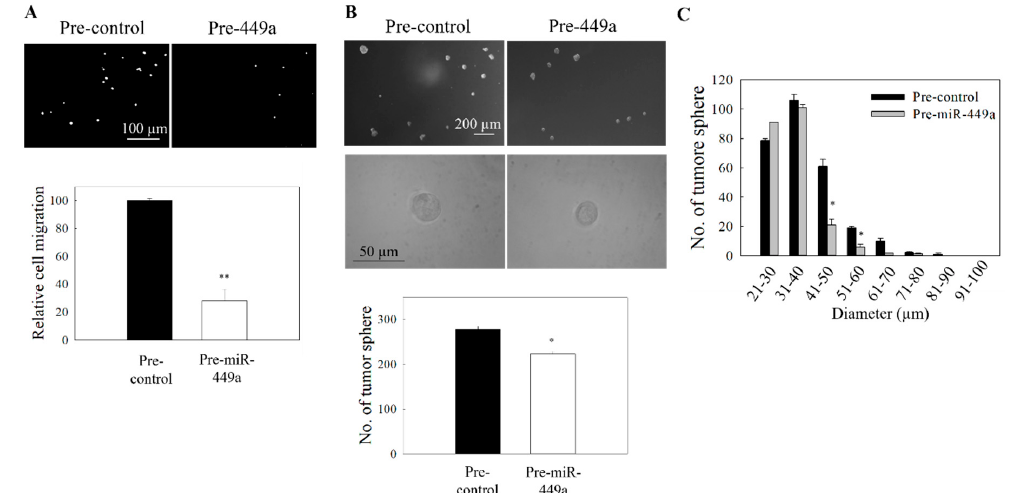
Figure 6. Effect of miR-449a on the migration and tumor sphere formation. C666-1 cells were transfected with pre-miR-449a. ( A ) Transwell migration of transfected cells. Upper panel: images of the migrated cells. Lower panel: quantitative analysis of the cells migration. ( B ) Tumor sphere formation assay. Upper panel: images of tumor spheres in culture well of ultralow attachment plate. Lower panel: quantitative analysis of spheroid number in pre-miR449a transfected cells. ( C ) Size distribution profile of tumor spheres. At least three independent experiments were carried out. * p < 0.05; ** p < 0.01 compared the control group.